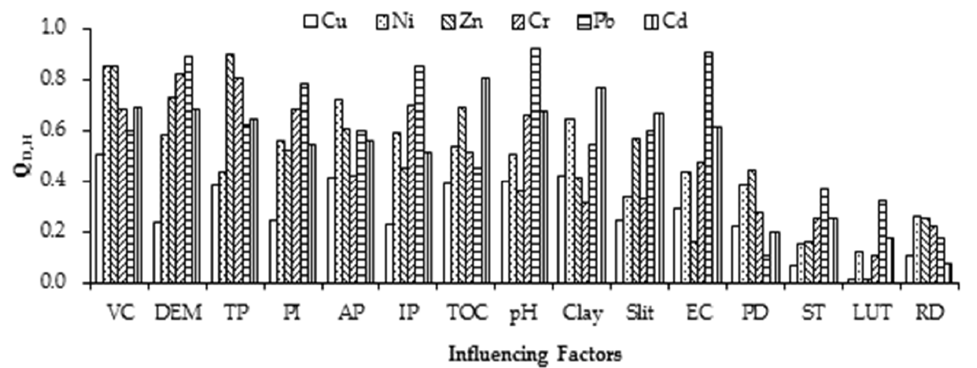
Figure 4. Influences of different factors on the explanatory power of sediment heavy metals with Q D,H value in the Inner Mongolia section of the Yellow River. Based on the factor detector, relatedness between heavy metals was confirmed. Cu had a small correlation with other heavy metals (Q D,H < 0.50), whereas Cd had a large correlation with other heavy metals ( Q D,H > 0.50). In addition, the correlation between Zn and Cr, Cd, and Pb was the strongest (Figure 6).